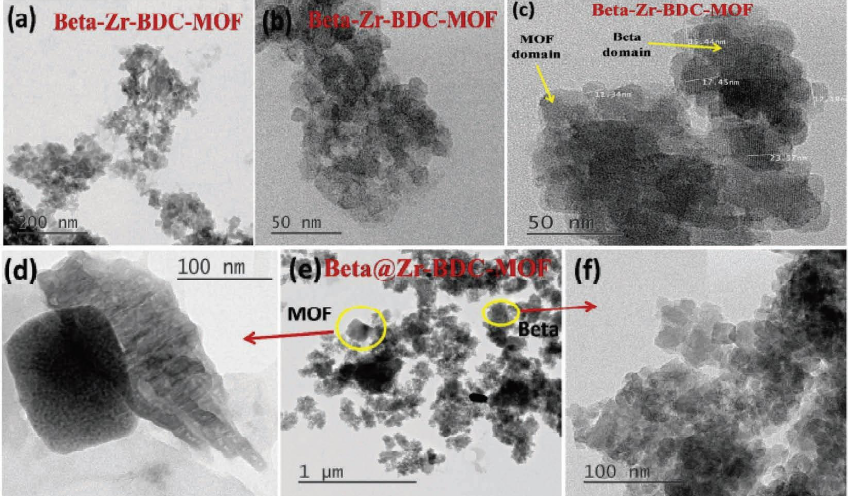
Figure 13: TEM images of (a–c) Beta-Zr-BDC-MOF, and (d–f) Beta@Zr-BDC-MOF adopted from [13].